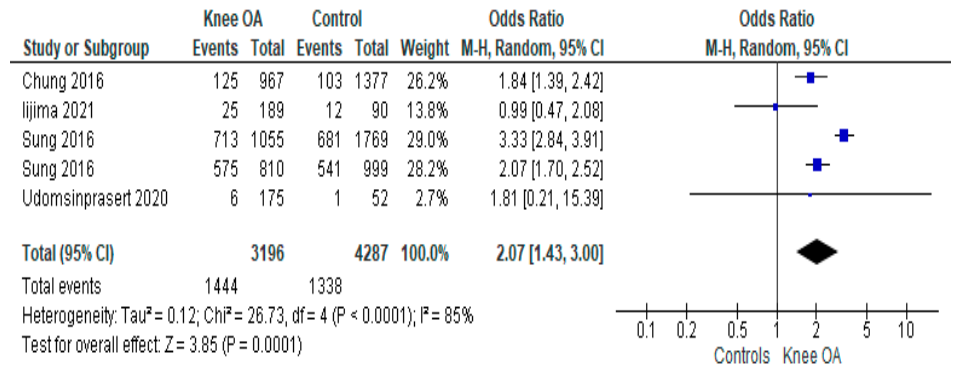
Table 1. Descriptive characteristics of the studies included.